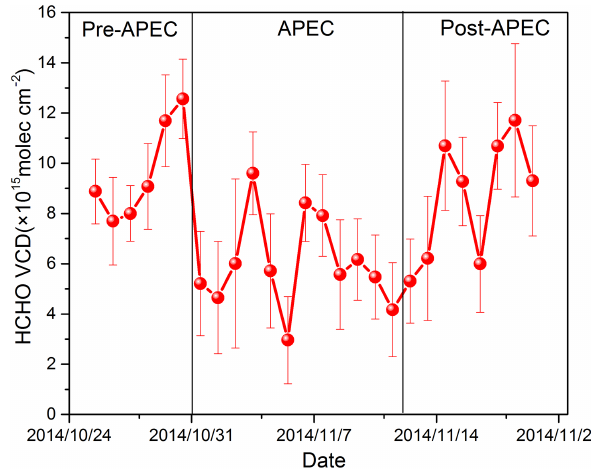
Figure 11. Daily averaged values of HCHO VCDs from 26 October to 20 November 2014. Error bars denote standard